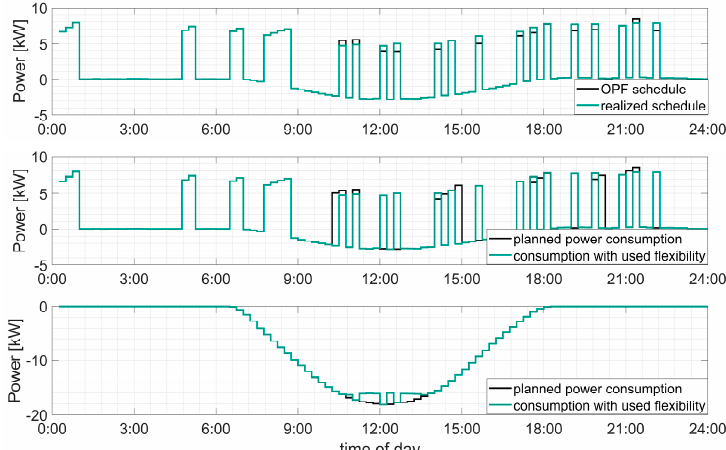
Figure 7. Top: a comparison of the resulting schedule from the OPF calculation and the related feasible schedule calculated with the method described in Section 2; middle: a comparison of the modified OPF input time series of power consumption and consumption with the use of flexibility for bus six; bottom: the same as in the middle for bus ten.